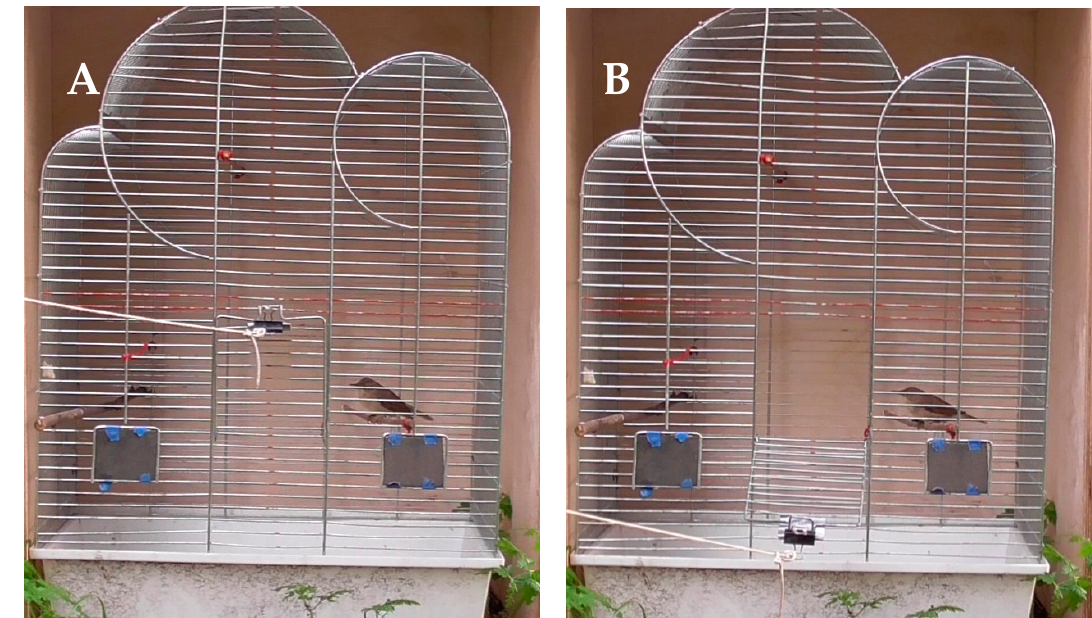
Figure 2. Experimental cage setting with the reed warbler before ( A ) and after ( B ) cage door opening.